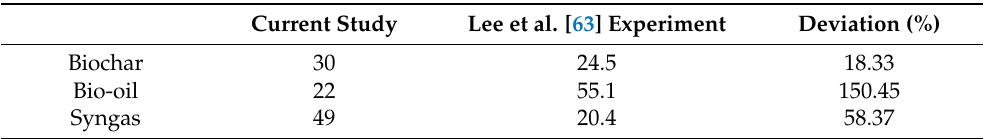
Table 7. Comparison of product yields (wt%) for bagasse.